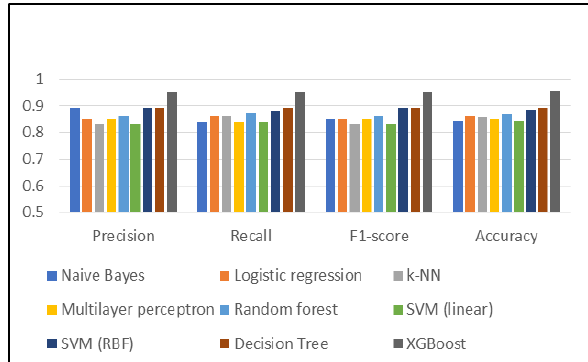
Figure 6 . Performance evaluation of all feature subsets using mRMR .